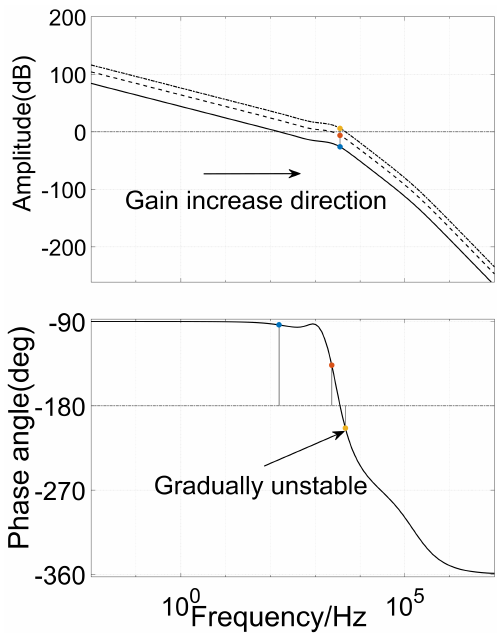
Figure 12. Admittance controller in the case of pure